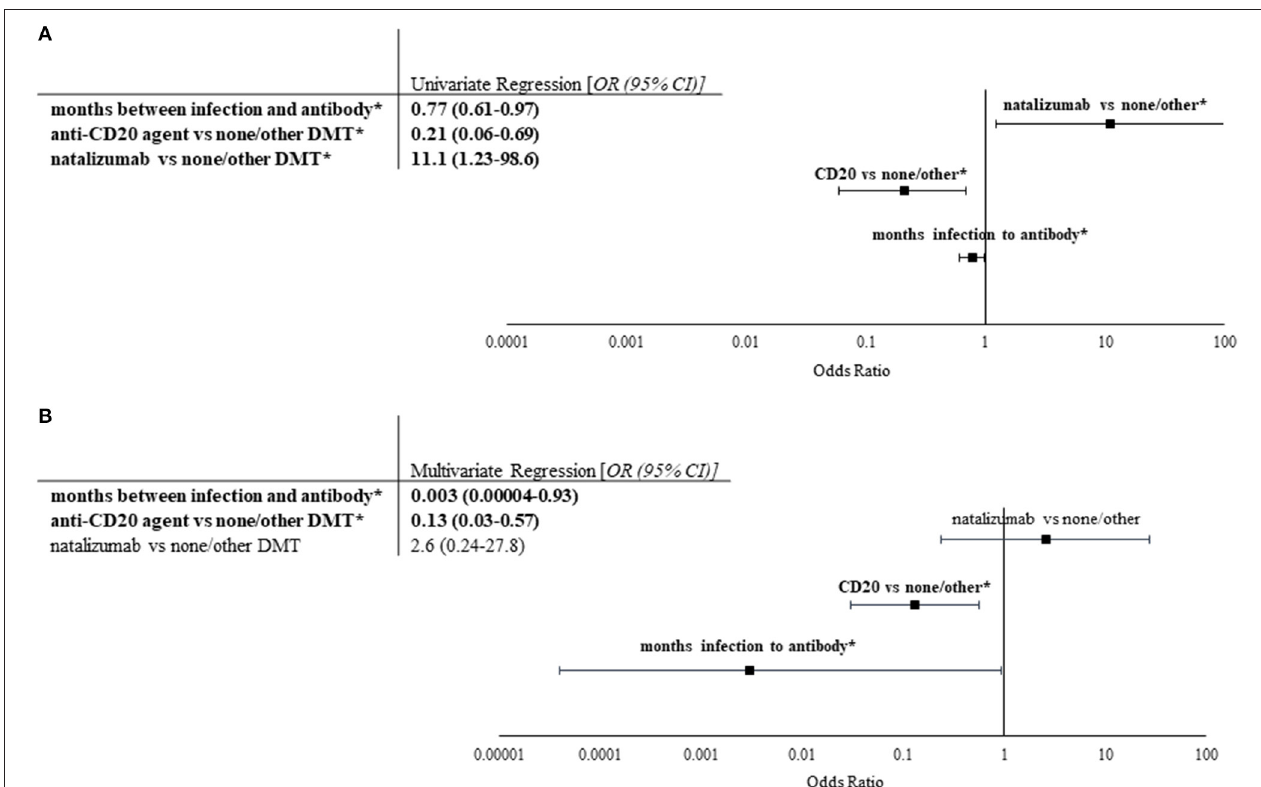
FIGURE 2 | Univariate and multivariate analyses of factors impacting seropositivity. Univariate and multivariate nominal logistic regression analyses were performed on patient characteristics, prior COVID-19 infection severity, and selected lab values based upon COVID-19 IgG antibody values ( n = 24 for seropositive, n = 34 for seronegative). (A) Univariate logistic regression was performed on characteristics of cohort. Odds ratios with 95% confidence intervals of all significant factors are listed in the table to the left. Significant correlations are indicated by bold font and *. Longer duration between COVID-19 infection and antibody collection as well as use of anti-CD20 treatment (rituximab or ocrelizumab) compared to no/other DMT were found to be predictive of negative post-infection COVID-19 IgG, whereas use of natalizumab vs. no/other DMT was found to be predictive of positive COVID-19 IgG. (B) Stepwise multivariate logistic regression utilizing Akaike information criteria was performed using significant factors in univariate analysis. Odds ratios with 95% confidence intervals of all factors evaluated are shown in the table (left) and figure (right). Only longer duration between COVID-19 infection and antibody collection and use of anti-CD20 treatment were found to independently decrease likelihood of seropositivity.